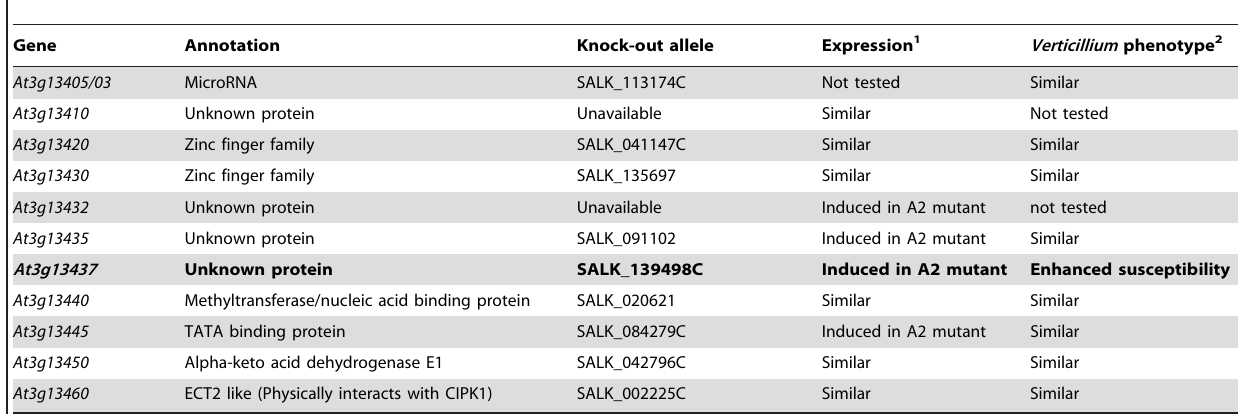
Table 1. Analysis of the genes flanking the activation-tag insertion site in mutant